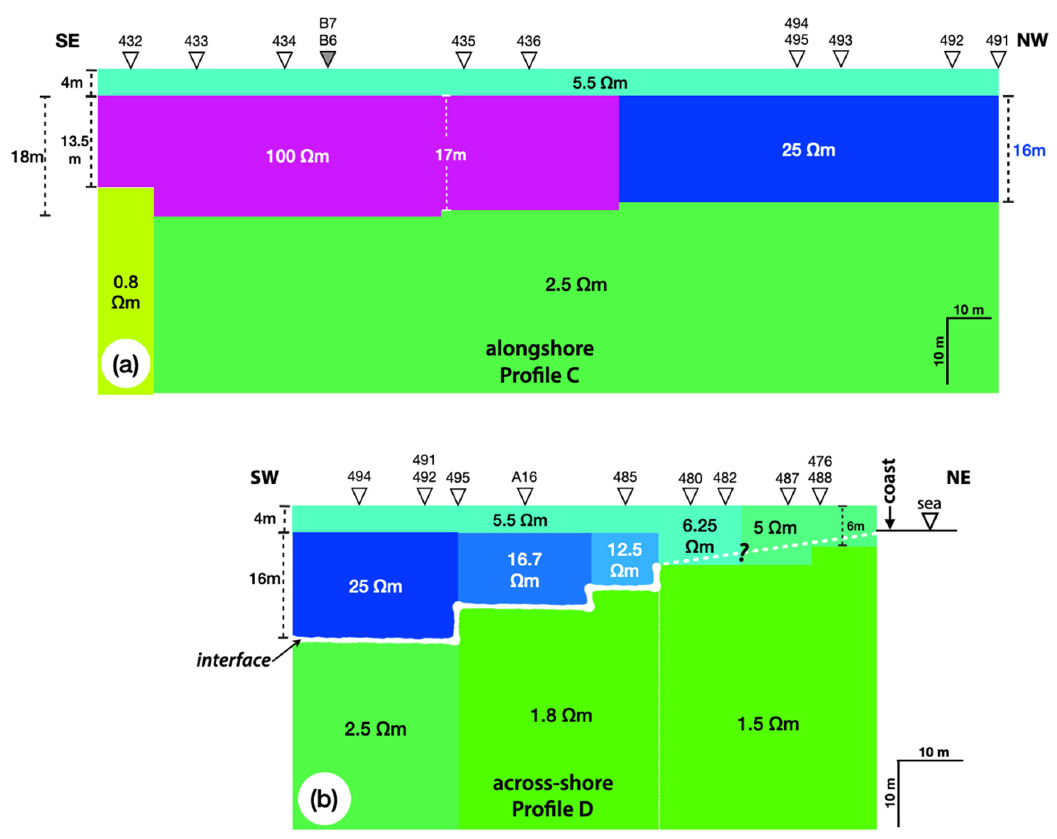
Figure 10. Stitched version of resistivity models from ( a ) Profile C along the western boundary and ( b ) Profile D in the northern part of the study site. The white line provides a rough guide to the geometry of the thinning of the freshwater lens towards the coast, where it becomes brackish to mildly saltwater.